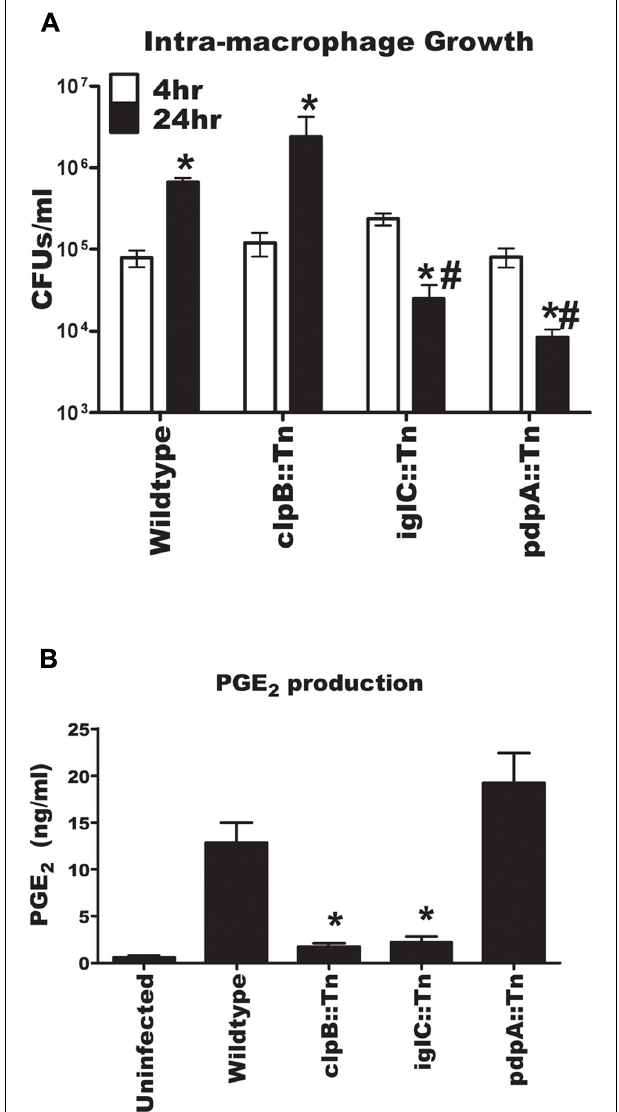
FIGURE 5 | Dissociation of intracellular growth and the induction of PGE 2 from bone marrow-derived macrophages (BMDMs). (A) BMDMs were inoculated with U112, U112 clpB ::Tn, U112 iglC ::Tn, or U112 pdpA ::Tn at an MOI of 100:1. CFU were determined at 4 and 24 h post-inoculation. Data represents three independent experiments and expressed as the means ± SEM. Asterisk “*” denotes statistical difference ( p ≤ 0.05) from corresponding 4 h sample. # denotes statistical difference ( p ≤ 0.05) from 24 h U112-infected BMDM ( n = 3). (B) BMDMs were inoculated with U112, U112 clpB ::Tn, U112 iglC ::Tn, or U112 pdpA ::Tn at an MOI of 100:1.Twenty-four hours after inoculation supernatants were collected and PGE 2 concentration was determined. Data represents three independent experiments and expressed as the mean ± SEM. Asterisk “*” denotes statistical difference ( p ≤ 0.05) from U112-infected BMDM.